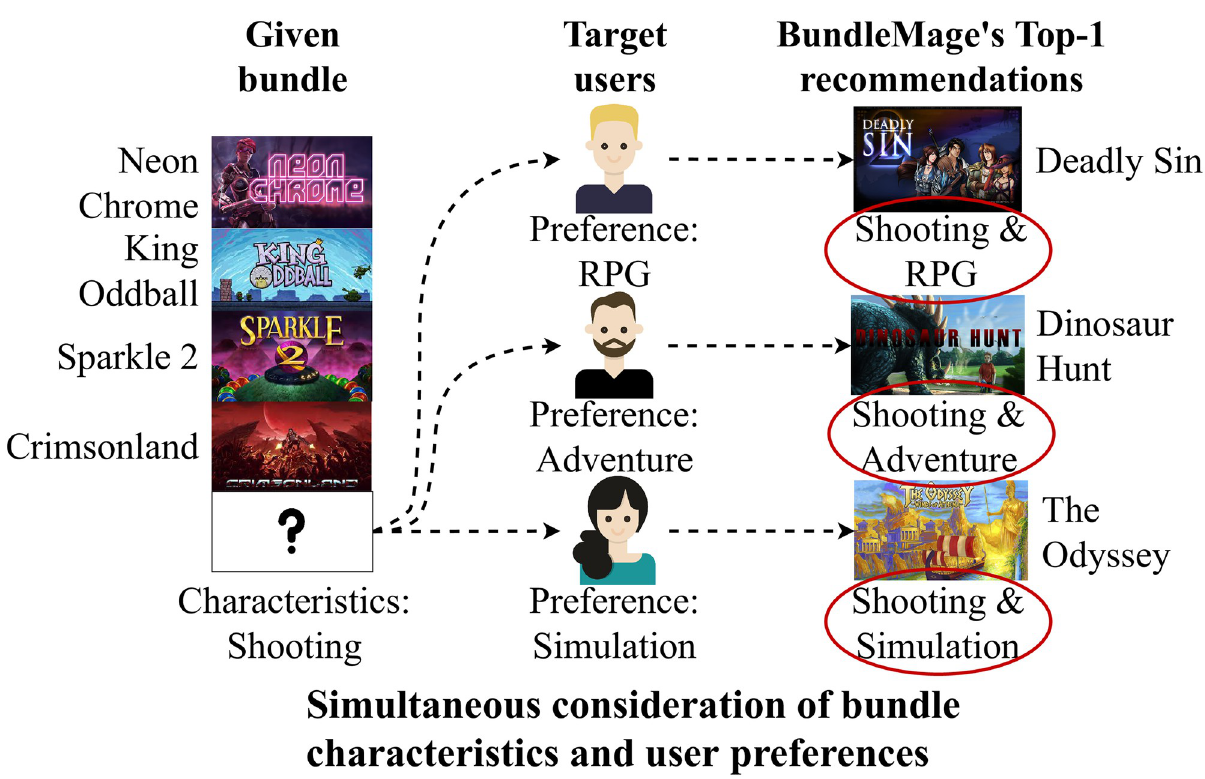
Fig 1. Top-1 recommendations of BundleMage for different target users in bundle generation. B UNDLE M AGE considers the characteristics of a given bundle and the preferences of target users for bundle generation. For instance, B UNDLE M AGE recommends a shooting and RPG game (e.g., Deadly Sin) for a bundle of shooting games and a target user A who prefers